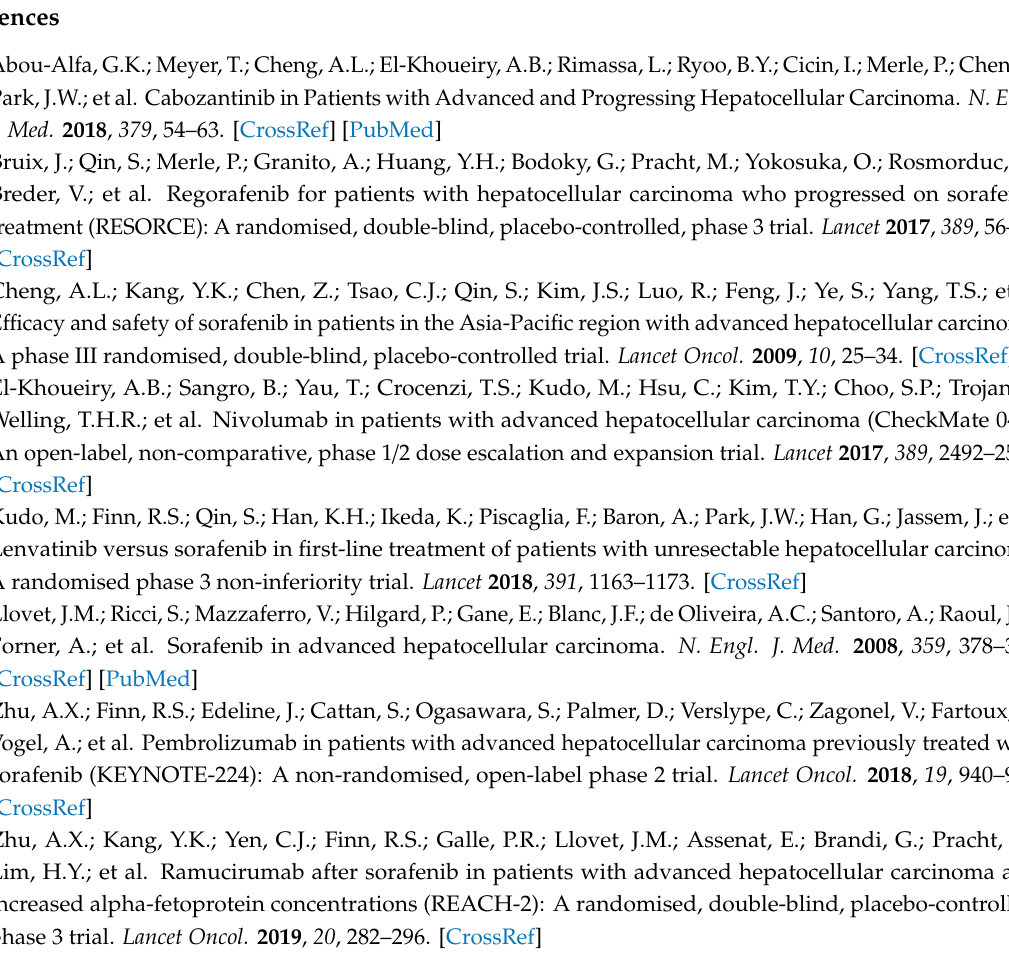
Figure S1: Western blot analysis results indicating the expression of various CDKs and their downstream molecules after transfection with siRNAs for 72